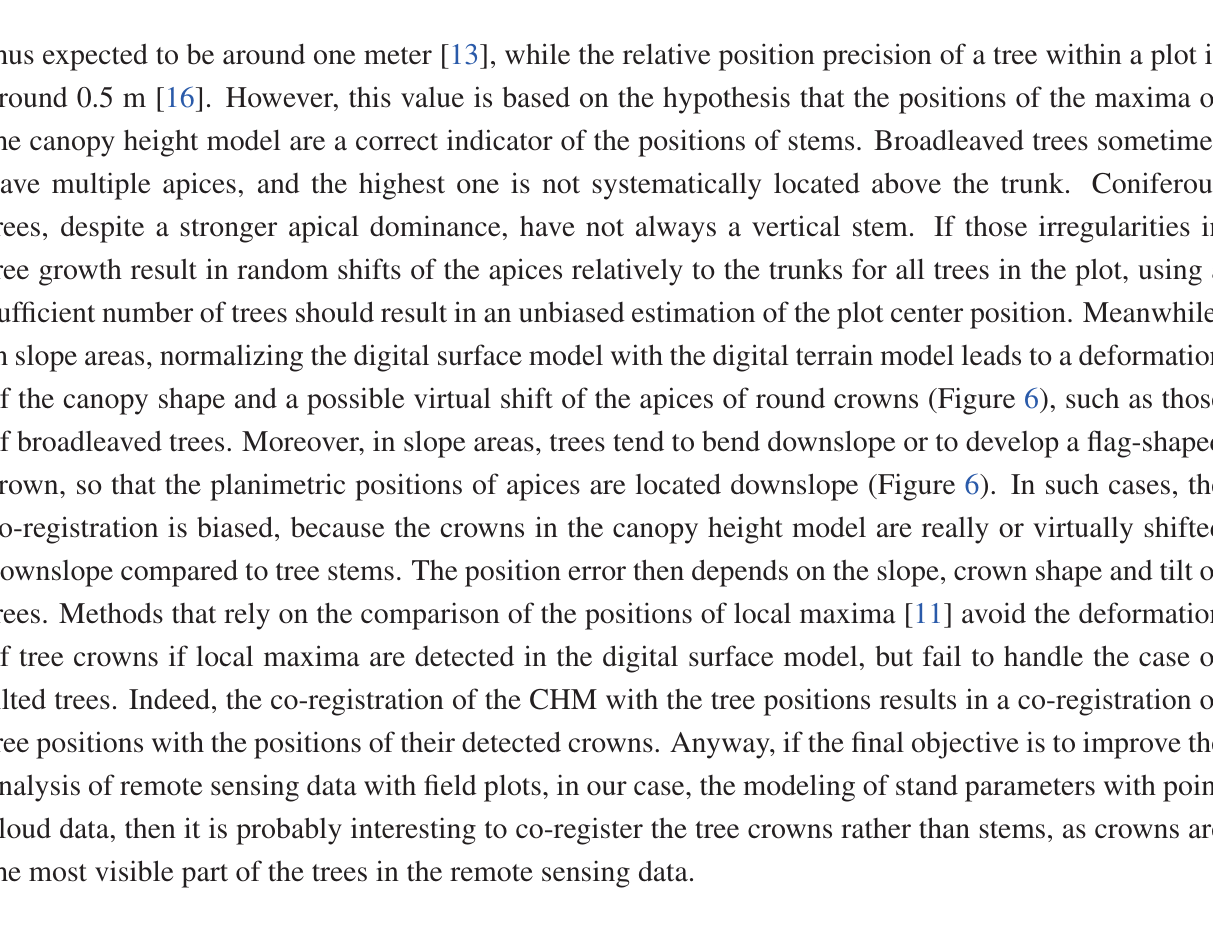
Figure 6. The difference between stem position and apex position in tilted trees ( a ); The shift of the apex position of a round crown when correcting a slope ( b , c